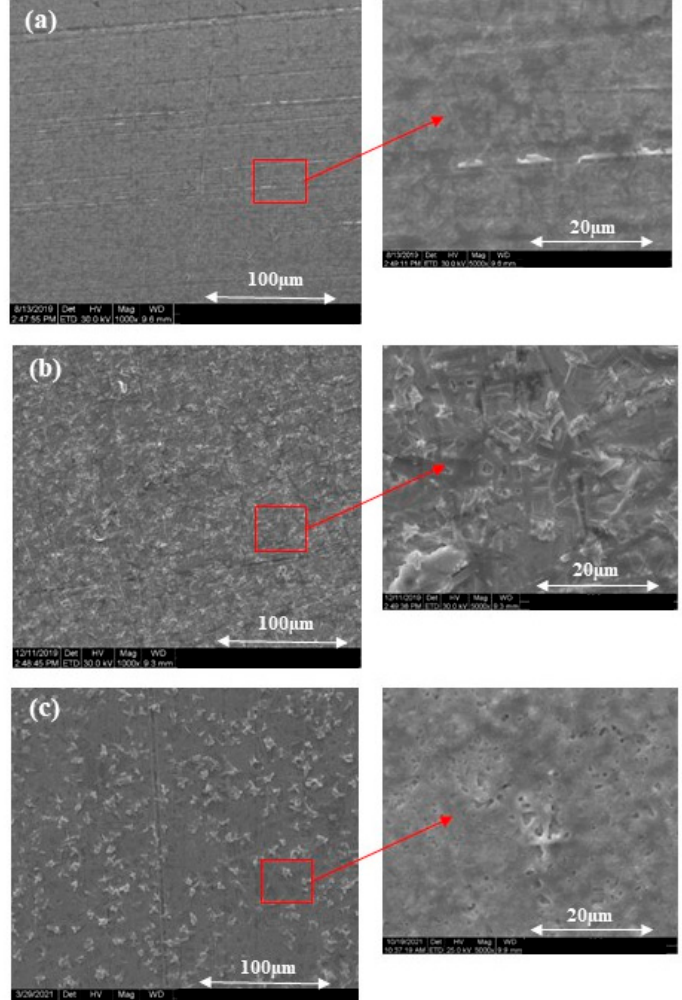
Figure 3. SEM micrographs of ( a ) SS/PbO 2 , ( b ) SS/TiO 2 /PbO 2 and ( c ) SS/TiO 2 /PbO 2 -10%B elec- trodes surface.